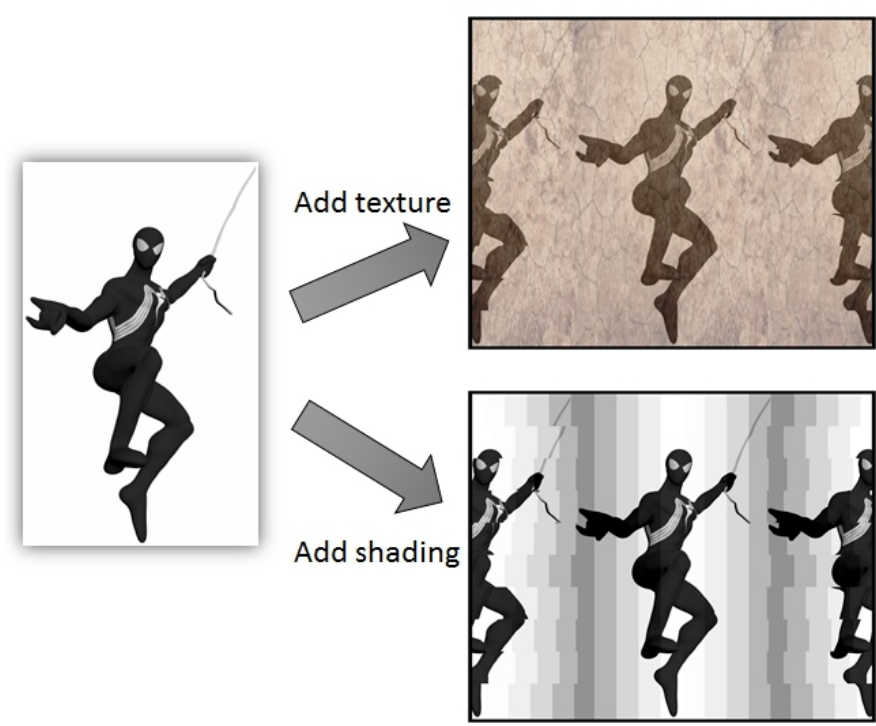
Figure 8. Our two methods to decorate the inner tag image: (1) adding textures and (2) adding shading